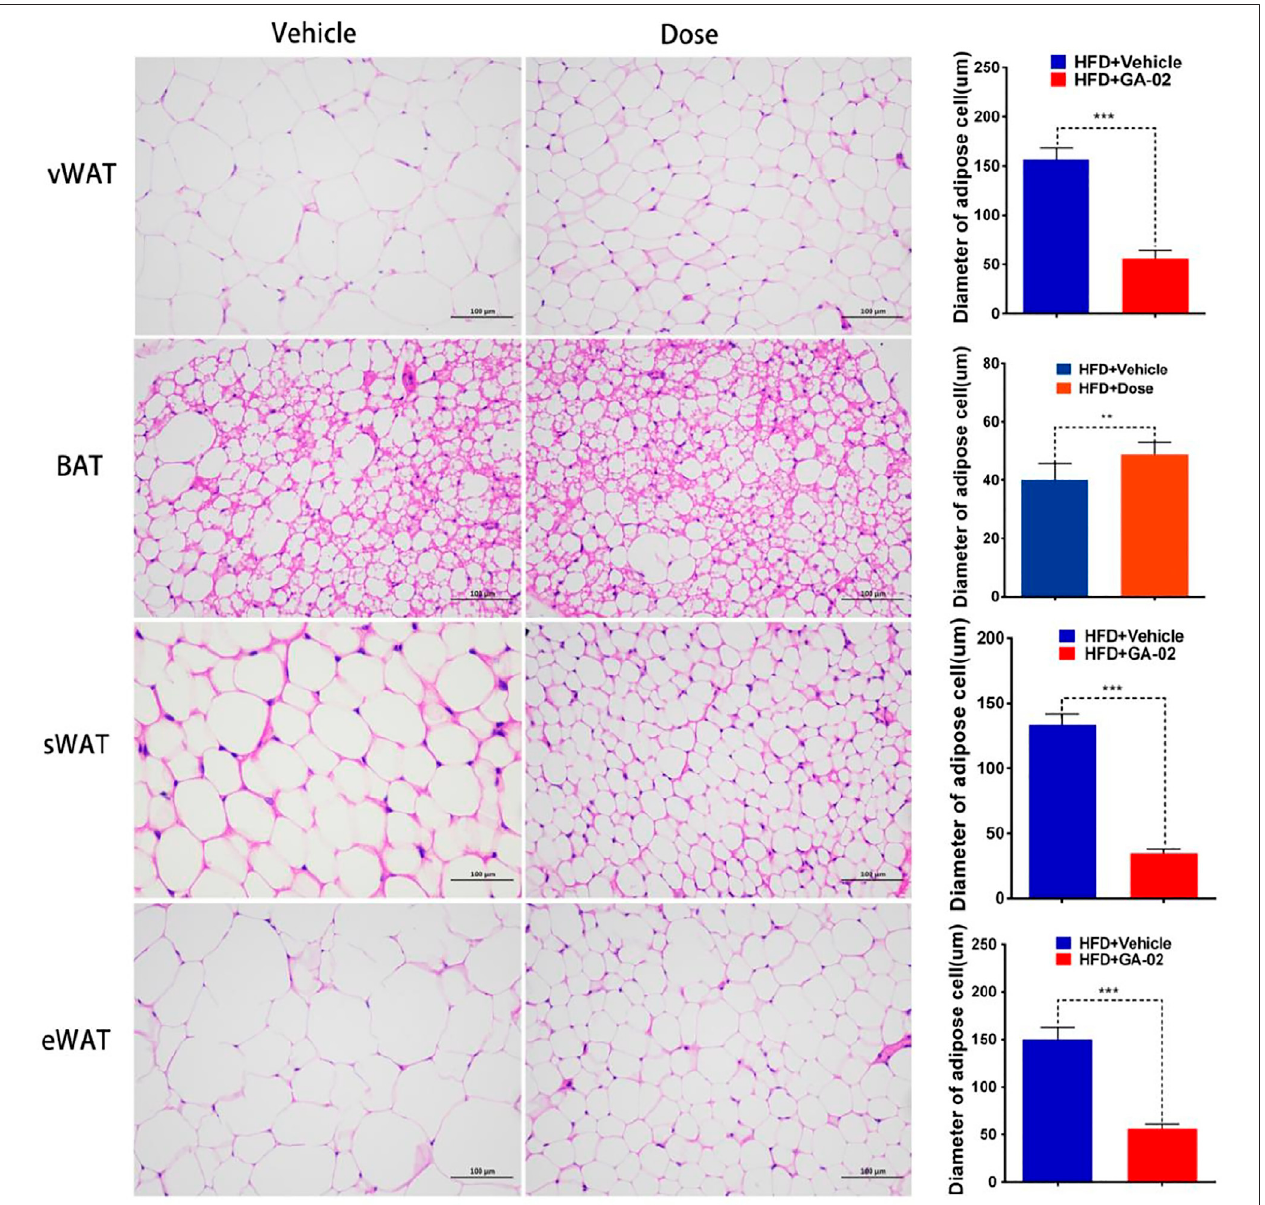
FIGURE 5 | GA-02 minimally affects mice de fi cient in leptin signaling. Eight-weeks old male db/db and ob/ob mice were exposed to a 2-weeks treatment with vehicle or GA-02 (20 mg/kg20 mg/kg; i.p.). (A) The body weight changes, (B) the percent of body weight changes (%), (C) the average daily food intakes over the fi rst week of treatment for db/db mice group ( n (cid:2) 5 for each group). (D) The body weight changes, (E) the percent of body weight changes (%), (F) the average daily food intake over the fi rst week for ob/ob mice group ( n (cid:2) 5 for each group). Body weight values are expressed as mean ± SEM (* p < 0.05, ** p < 0.01, *** p < 0.001).